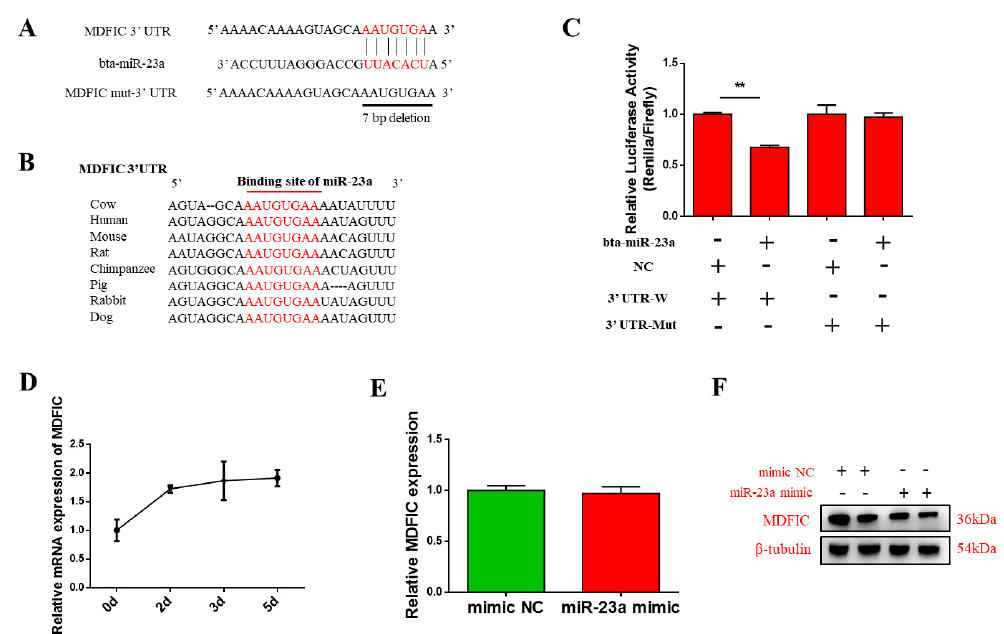
Figure 4. MDFIC gene is directly targeted by bta-miR-23a. ( A ) The predicated binding sites of bta-miR-23a in the 3 ′ -UTR of MDFIC . Deletion of the seed region (in red) in the mutant 3 ′ -UTR reporter. ( B ) The conservation of mature bta-miR-23a binding site in eight different species. ( C ) The relative luciferase activities of HEK293T cells co-transfected with the MDFIC 3 ′ -UTR mutant or wild-type dual-luciferase reporter and bta-miR-23a mimic or the mimic NC at 48 h. ( D ) Expression pattern of MDFIC during MD. The mRNA ( E ) and protein ( F ) levels of MDFIC in PDGFR α− bPCs transfected with bta-miR-23a mimics or negative control at 48 h. β -tubulin was used as the reference gene. Results are representative of the mean (± SD) of three independent analyses. ** p < 0.01.